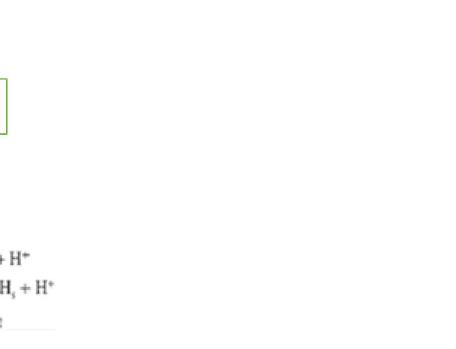
Scheme 1. Mechanism of photocatalysis by NT1 catalyst under